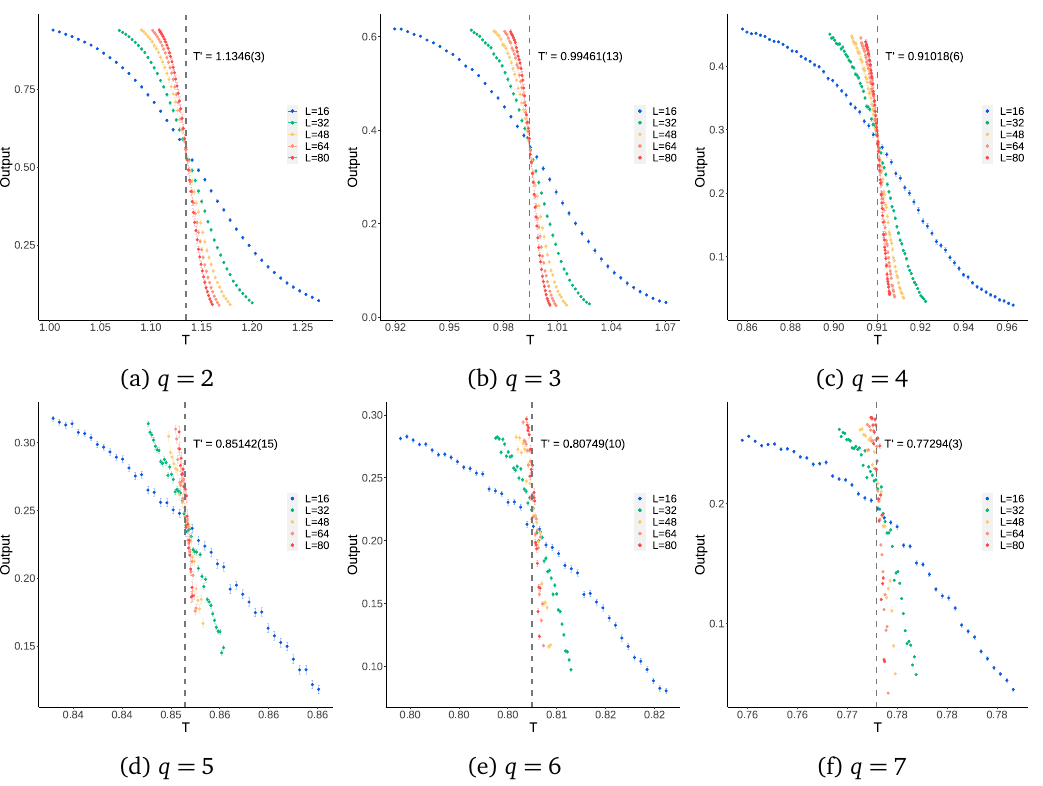
Figure 6: The relationship between temperature and the average output of an ensem- ble of 10 independently trained ANNs – training with MC data of the ferromagnetic square-lattice Ising model, and testing with MC data of the ferromagnetic q -state Potts model on a square lattice. The error bars shown are 99.7% confidence intervals of the ensemble